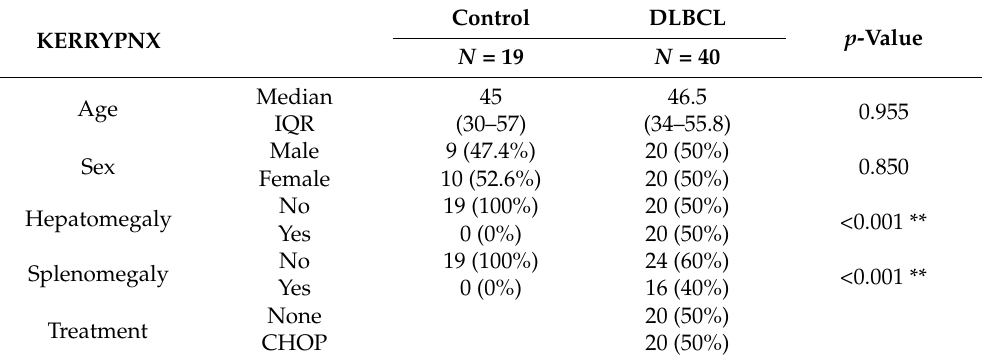
Table 1. The comparison between normal controls and DLBCL patients regarding demographic and clinical data.